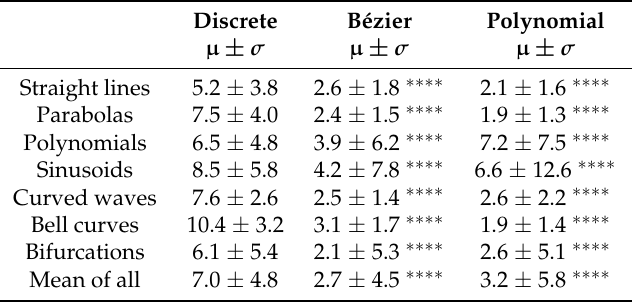
Table 4. Mean relative error of the length measurement methods in % after centerline extraction by erosion compared to the continuous ground truth. Significance was proven for the reduction of the error compared to the discrete length for each function type ∗∗∗∗ p < 0.0001.